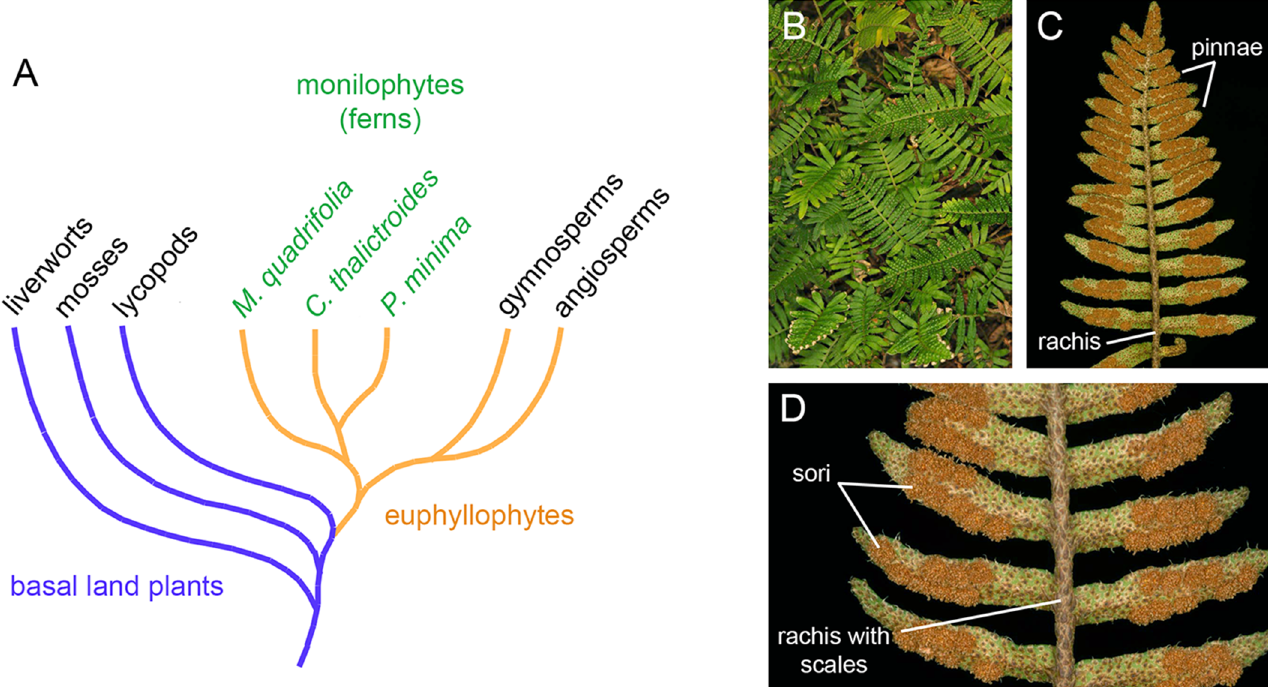
Fig 1. Phylogenetic position and habit of Pleopeltis minima . (A) Simplifiedsummary of phylogenetic relationships among major plant lineages relevant for the present study [3, 17, 24]. Note that some molecularphylogenies recover a clade composedof liverworts and mosses as sister to vascular plants [25, 26]. The fern (“monilophytes”) clade is the sister group to seed plants, gymnospermsand angiosperms. Within ferns, P . minima belongsto the order Polypodiales and is more closely related to Ceratopteris thalictroides , while Marsileaquadrifolia belongsto the order Salviniales and Lygodiumjaponicum to the order Schizaeales. (B) Habit of P . minima growingas epiphyteupon a tree trunk. (C) Abaxialside of leaf surface showingform and organization. (D) Portion of fertile leaf showingpositionof sori and scales. Scale bars: 5 mm.